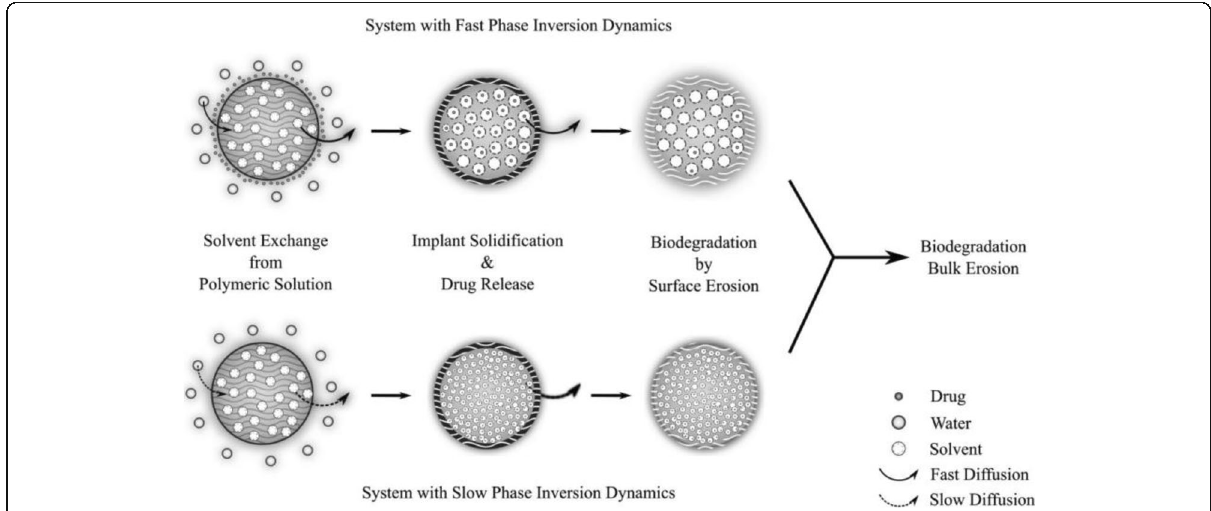
Fig. 3 Mechanism of gel formation and drug release. Reproduced with the permission from Juvekar et al. [6]. Solvent exchange occurs from the polymeric solution. Gel solidification during coagulation of the polymeric solution and simultaneously diffusion of the drug takes place, later than polymeric degradation either by surface erosion or throughout the polymeric matrix system. System with fast phase inversion dynamics implant shows burst release of drug, whereas system with slow phase inversion dynamics, the burst release is not